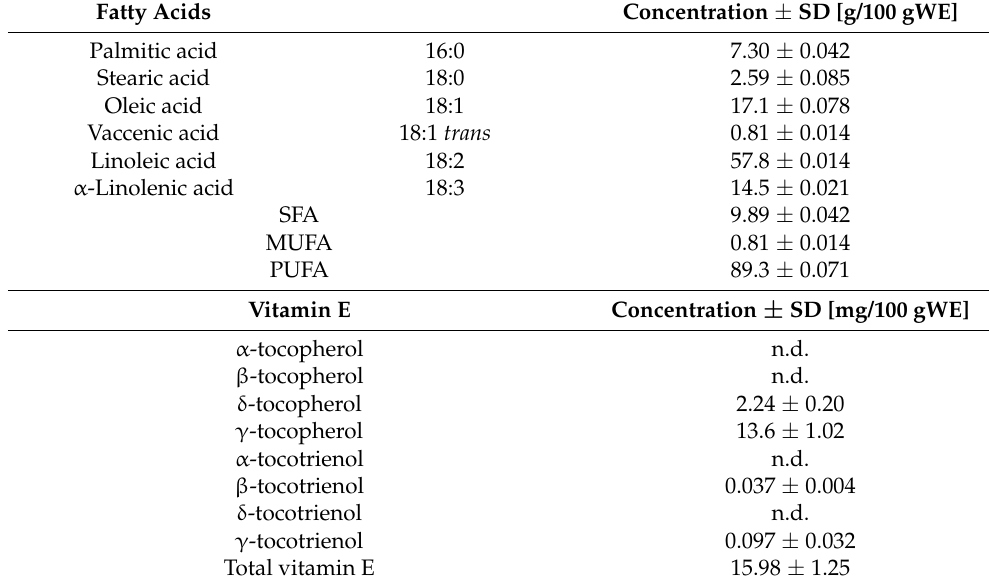
Table 2. Detailed fatty acid and vitamin E congener composition of the walnut extract. Fat content was determined gas-chromatographically. The cut-off for signals was at 0.05% of the strongest signal obtained. Data are displayed as g/100 g extract for fatty acids and mg/100 g for vitamin E congeners. Tocopherols were determined by HPLC/FD. Note: n.d. = not detected; SFA = saturated fatty acids; MUFA = mono-unsaturated fatty acids; PUFA = poly-unsaturated fatty acids. Fatty Acids Palmitic